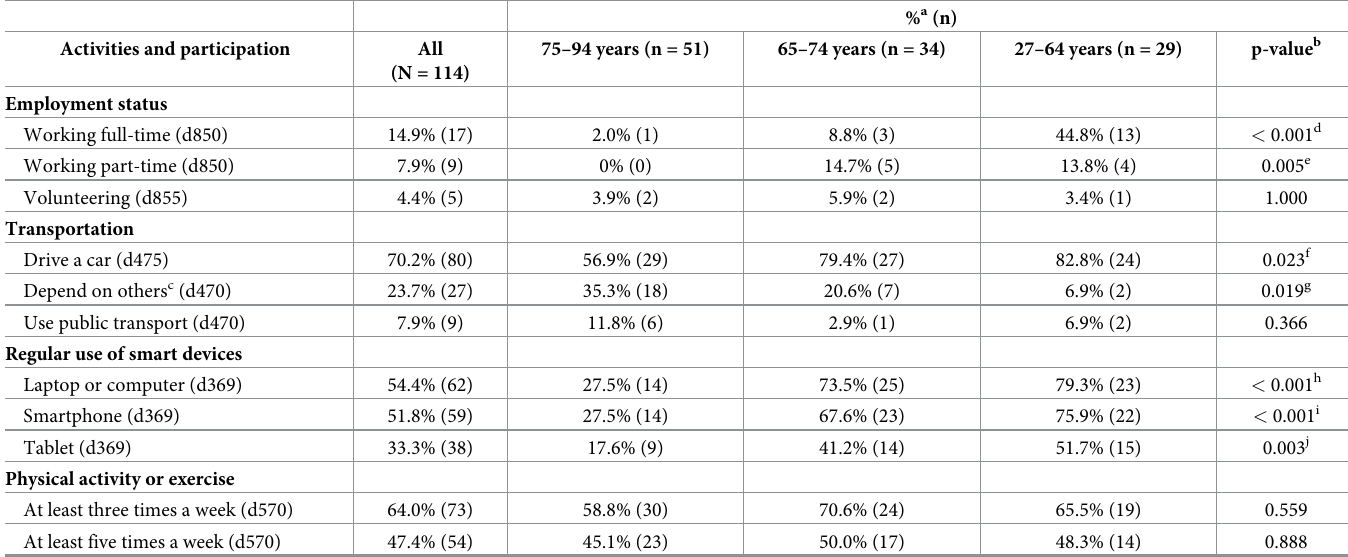
Table 4. Survey items linked to the ICF component of activities and